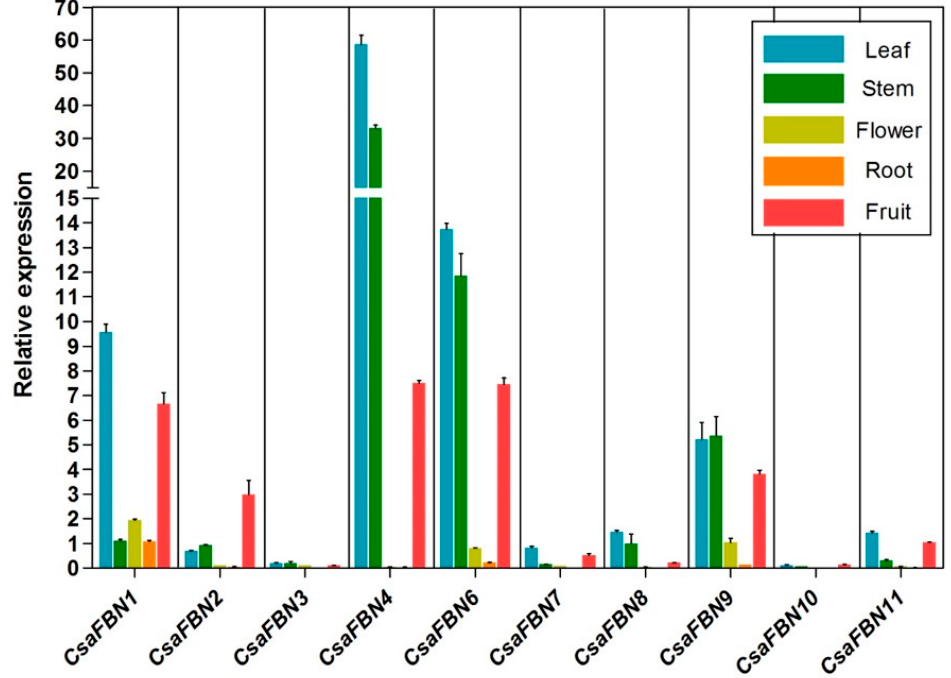
Figure 3. Expression profiles of cucumber FBN genes in various tissues. Plant tissues such as leaf, stem, flower, root and fruit were taken from cucumber plants raised for two months. Transcript expression was analyzed by quantitative real-time RT-PCR. The EUKARYOTIC TRANSLATION INITIATION FACTOR 4A1 (eIF4a, Csa7G450710) gene from cucumber was used as an internal control. Biological triplicates were averaged. Bars indicate the standard error of the mean.